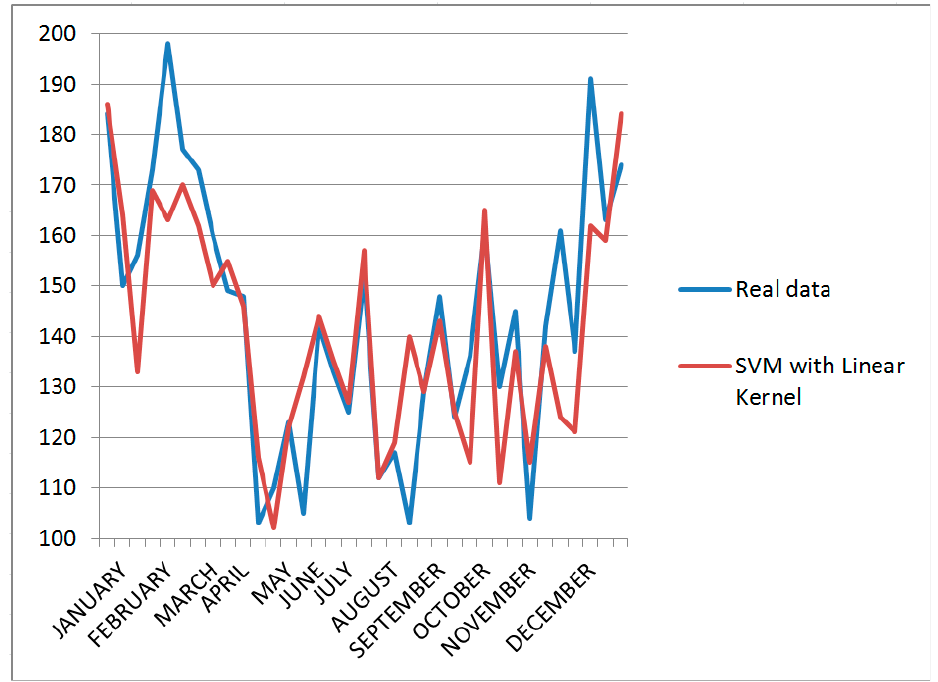
Figure 10. Comparison of the predictions of the holidays with respect to the actual data of 2018.